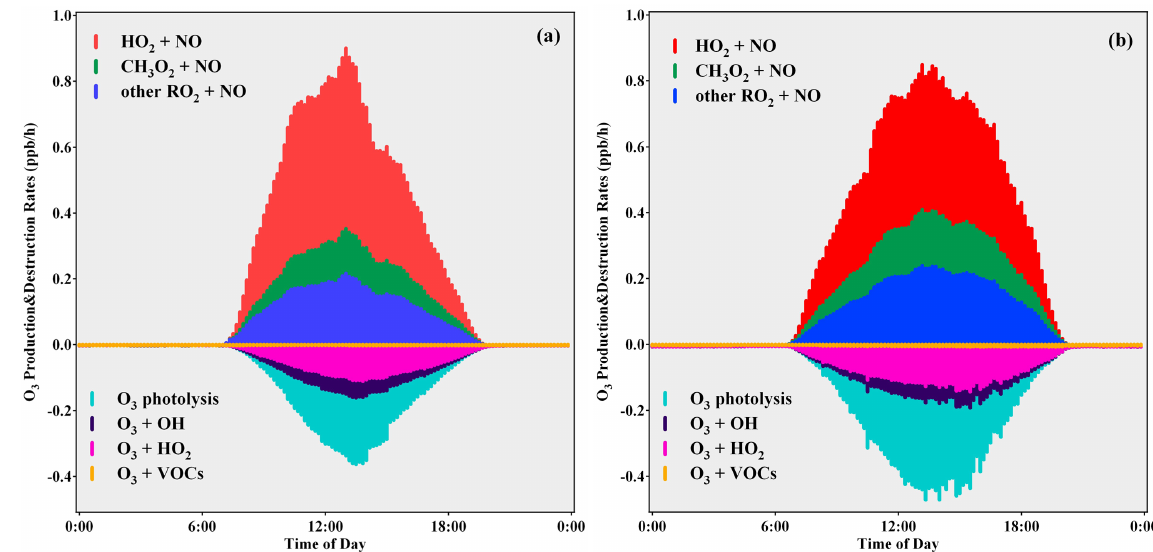
Fig. 5. Breakdown of O 3 in situ production and destruction rates at WLG in (a) spring and (b)